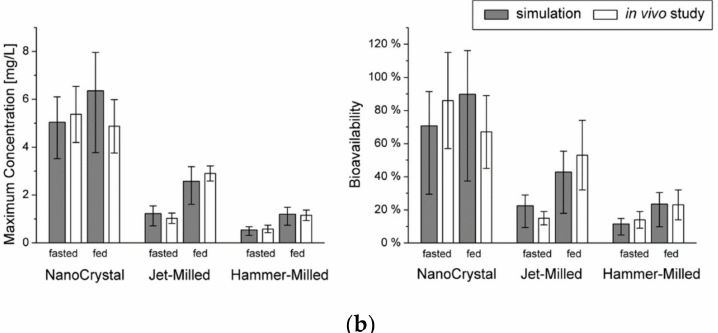
Figure 5. ( a ) Particle size distribution for the three cilostazol suspensions. Symbols represent the data from [47] (reprinted with permission from [23], Elsevier, 2010), the lines show the fit to a log-normal distribution function. ( b ) Comparison of the maximum concentration and bioavailability predicted from the particle size with the experimentally obtained values (mean and s.d. reprinted with permis- sion from [23], Elsevier, 2010) of the three suspensions under fasted and fed conditions. The error bars represent the variability due to the inter-individual variability of the cilostazol clearance.